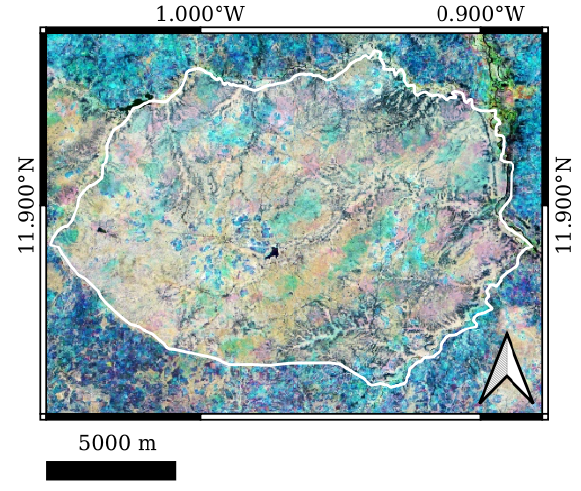
Figure 5: 3PTS image of the Sondre Est Pastoral Zone from 2017, with the zone’s borders in white. EPSG 4326